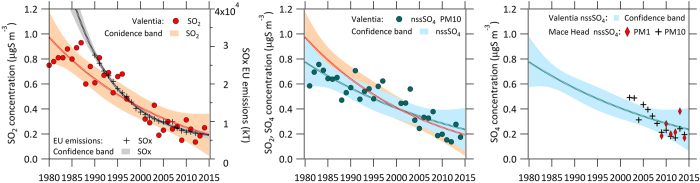
Sulphur air pollution trends.(Left) SO2 pollution levels in terms of μg S m−3 measured at Valentia Observatory over the period of 1980–2014 and European SOx emissions over the period of 1988–2014. Shaded areas represent the confidence bands (95%) of exponential fits. (Middle) SO2 confidence bands, as in left panel, overlaid with nss-SO4 PM10 pollution levels in terms of μg S m−3 measured at Valentia Observatory over the same time period of 1980–2014 and its confidence bands. (Right) nss-SO4 PM10, for 2001–2014, and nss-SO4 PM1, for 2009–2014, (again both in terms of μg S m−3) observed at Mace Head with the 95% confidence bands from Valentia Observatory superimposed.